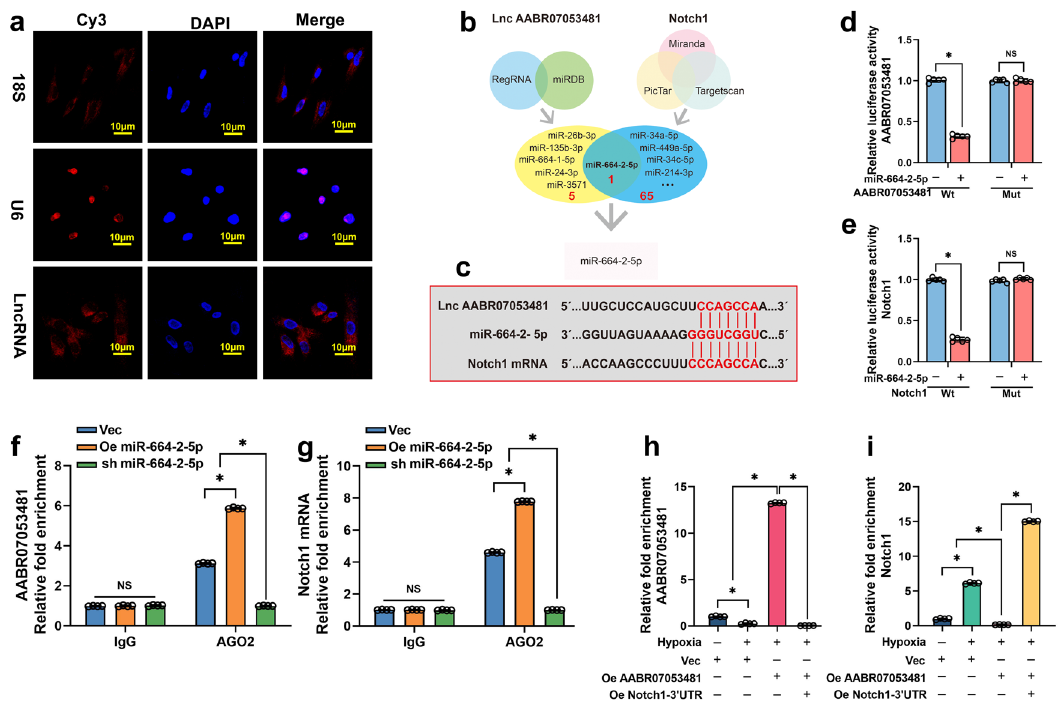
Fig. 4 LncAABR07053481 functions as a ceRNA and sponges miR-664-2-5p in BMSCs. a RNA fl uorescence in situ hybridization (RNA-FISH) detection of the subcellular localization of LncAABR07053481, 18S, and U6 were used as positive control. (n = 4). b Bioinformatics tools predict the miRNAs that may bind to the untranslated region at the 3 ’ end of Notch1 mRNA ( Notch1 mRNA 3 ′ UTR) and LncAABR07053481. c Binding sites of miR-664-2-5p with LncAABR07053481 and Notch1 mRNA 3 ′ UTR. d , e Luciferase reporter assay shows that miR-664-2-5p binds to LncAABR07053481 and Notch1 mRNA ( n = 5). f – h RNA immunoprecipitation (RIP) detection of LncAABR07053481 enrichment to miRNA ribonucleoprotein complexes (miRNPs) ( n = 4). g – i RIP detection of enrichment of Notch1 mRNA to miRNPs ( n = 4). Data were shown as mean ± SD. * P < 0.05; In ( d – i ), statistical signi fi cance was calculated by one-way ANOVA with Tukey ’ s post hoc